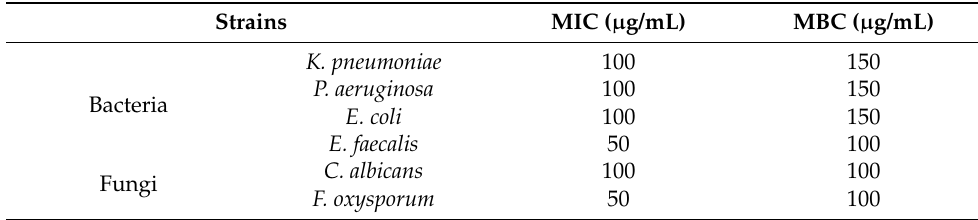
Table 2. MIC and MBS of the crude oils of S. edelbergii against various bacterial and fungal strains. Strains MIC (µg/mL) MBC (µg/mL) K. pneumoniae 100 150 P. aeruginosa 100 150 Bacteria E. coli 100 150 E. faecalis 50 100 100 Fungi